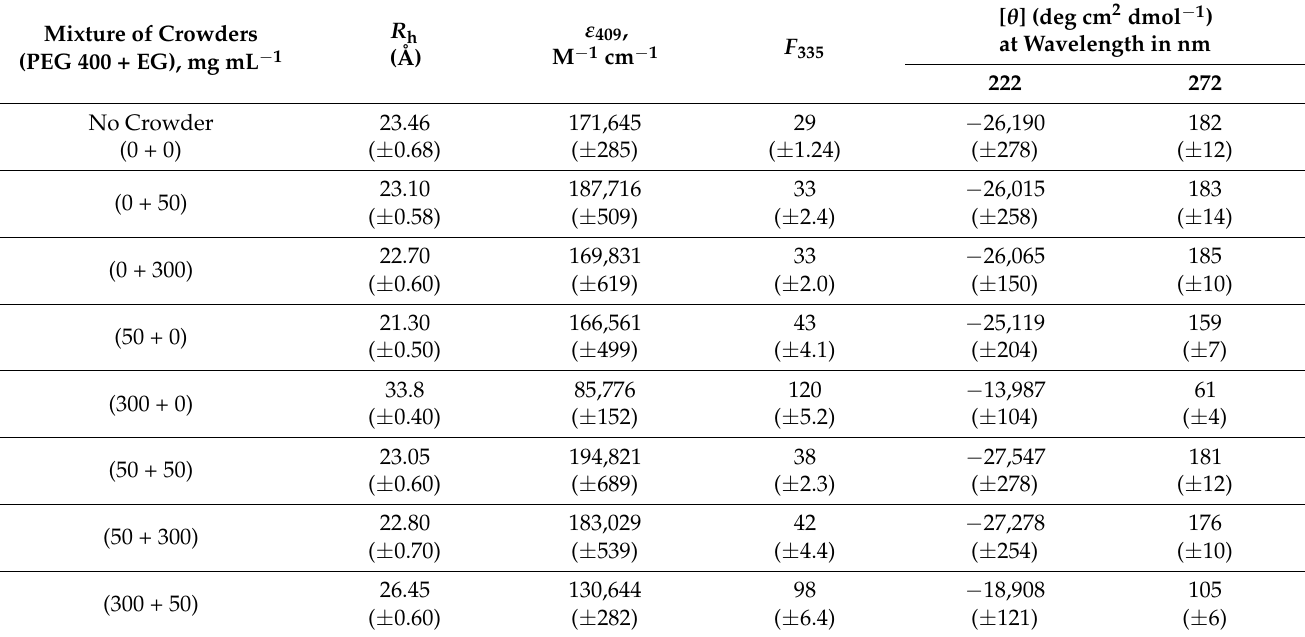
Table 3. Comparison of spectral properties of Mb in the presence of crowders (PEG 400 and EG) individually and their mixtures (PEG 400+ EG) at pH 7.0 and 25 ◦ C a